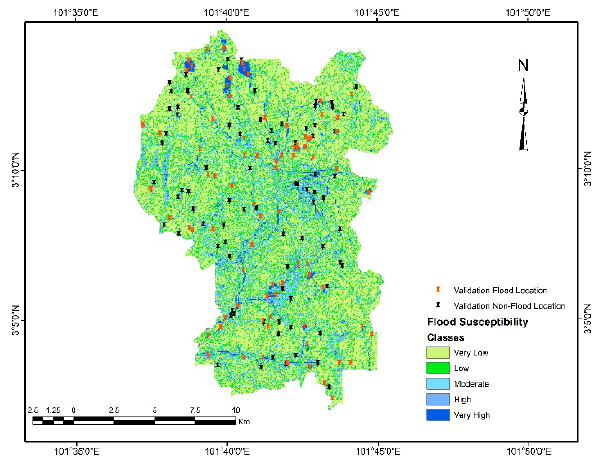
Figure 4: Flood susceptibility map generated by LR